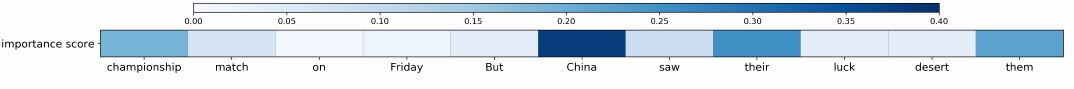
Figure 7. The importance scores distribution of a case in